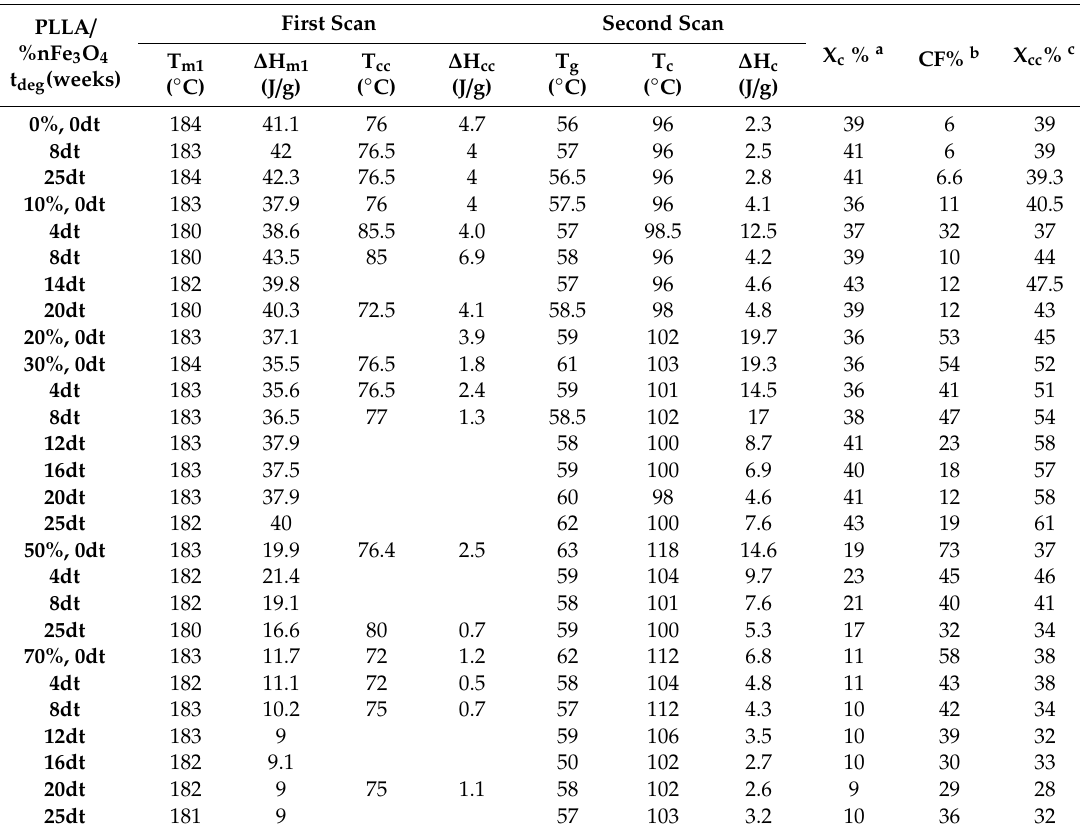
Table 3. Parameters obtained by DSC on the PLLA-nFe 3 O 4 sca ff olds: Tm = melting